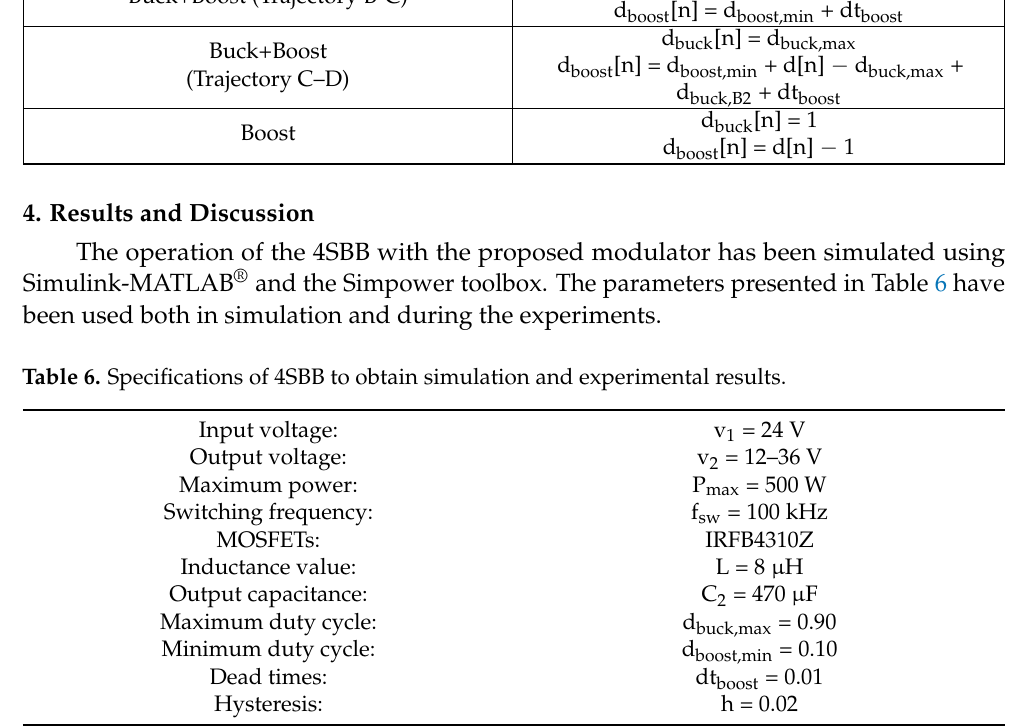
Table 6. Specifications of 4SBB to obtain simulation and experimental results.